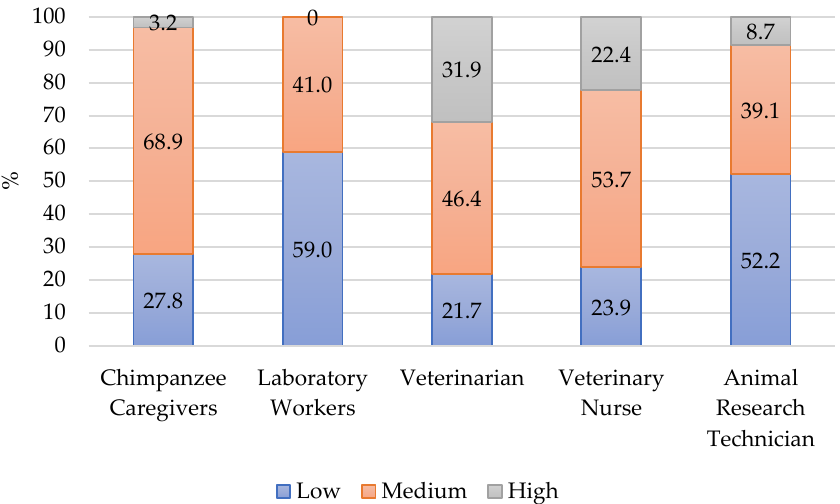
Figure 3. Percent of respondents in each category for STS. Laboratory Workers (N = 170) [21], Veterinarian (N = 69) [12], Veterinary Nurse (N = 23) [12], Animal Research Technician (N = 23) [12].